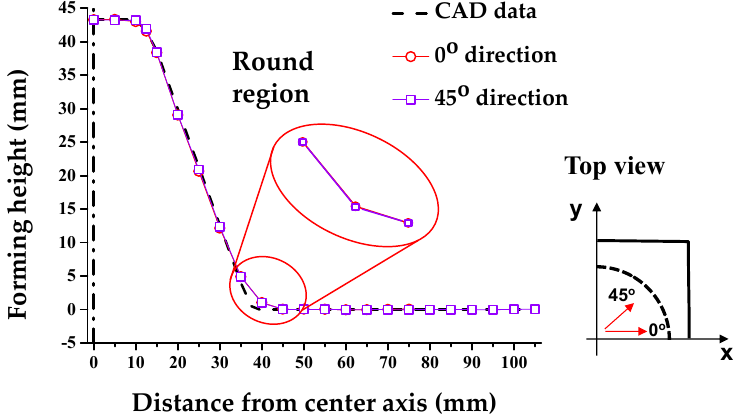
Figure 13. Comparison of the cross-sectional shape after the counter SPIF according to the direction.